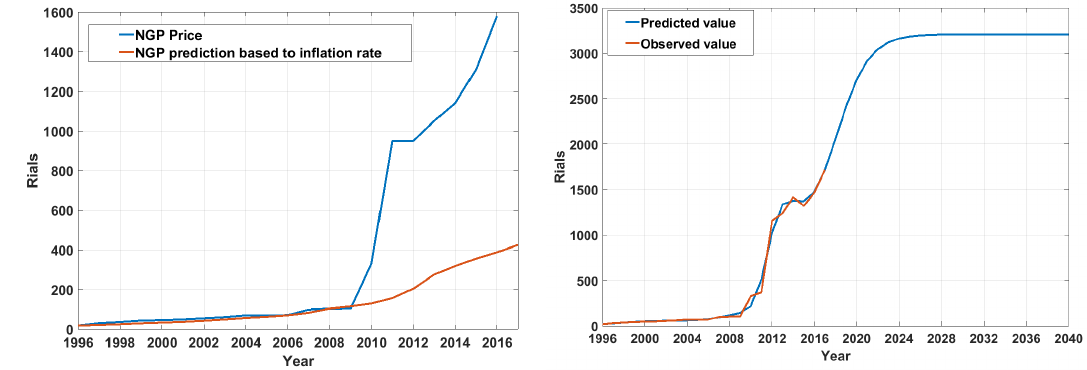
Figure 5. Natural gas price trends.